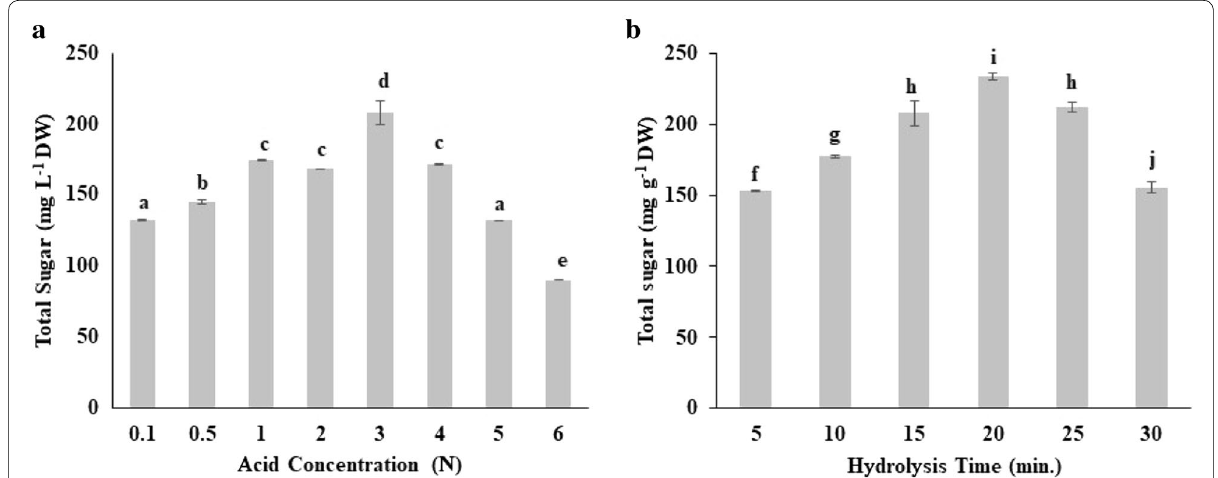
Fig. 8 Effect of a acid concentrations, b microwave hydrolysis time on extraction of total sugar. The means and standard deviations of the three replicates are indicated. (P < 0.05 for different